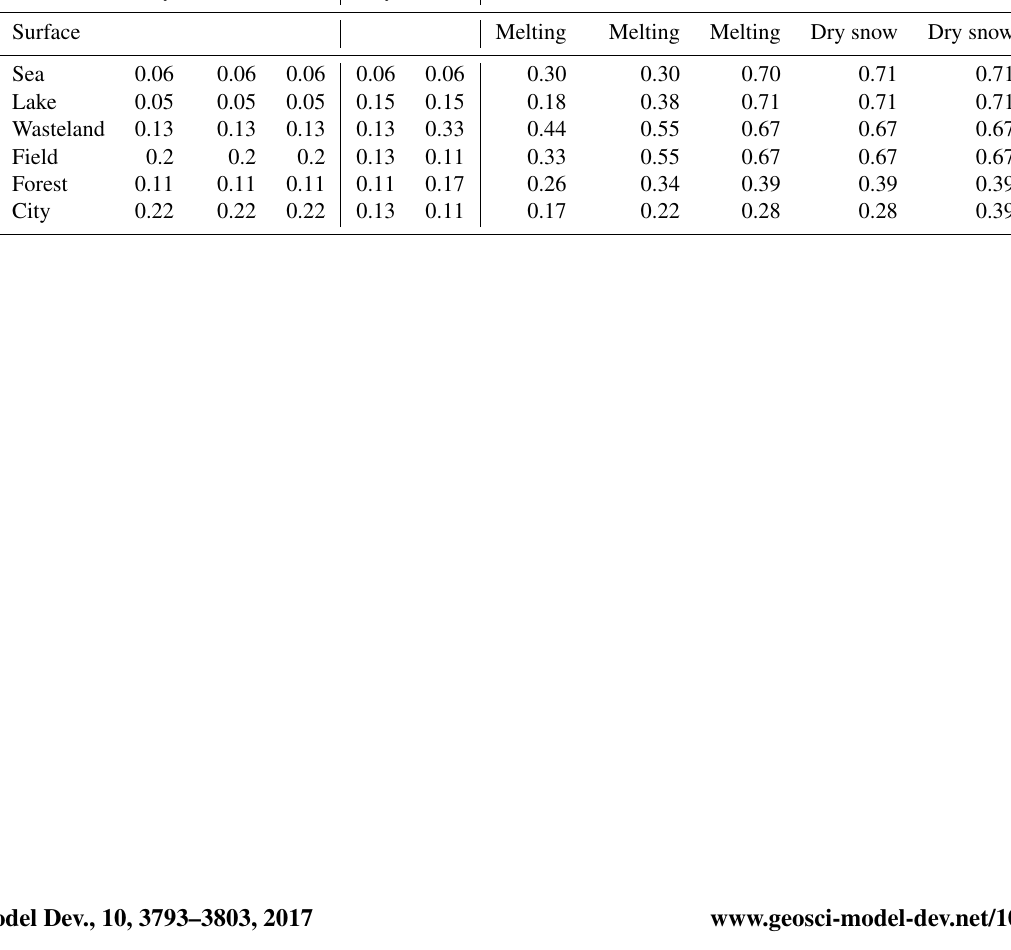
State of the ground